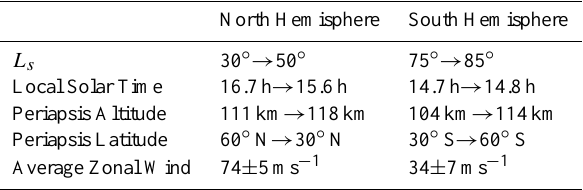
Table 1. Northern and Southern Hemisphere data used to derive the average zonal wind from MGS phase 2 accelerometer data, adapted from Withers